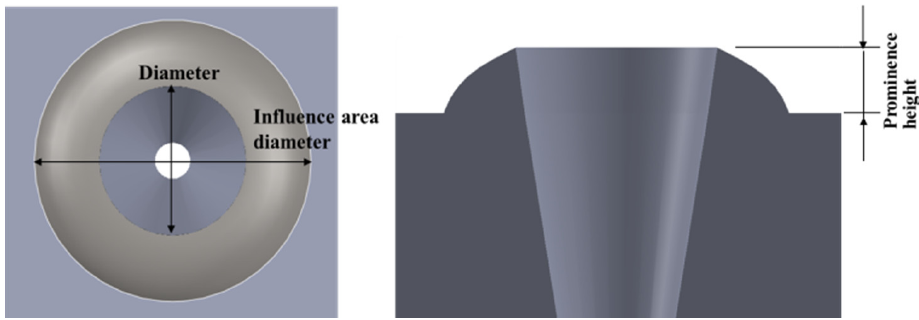
Figure 9. Schematic diagram of hole size measurement.